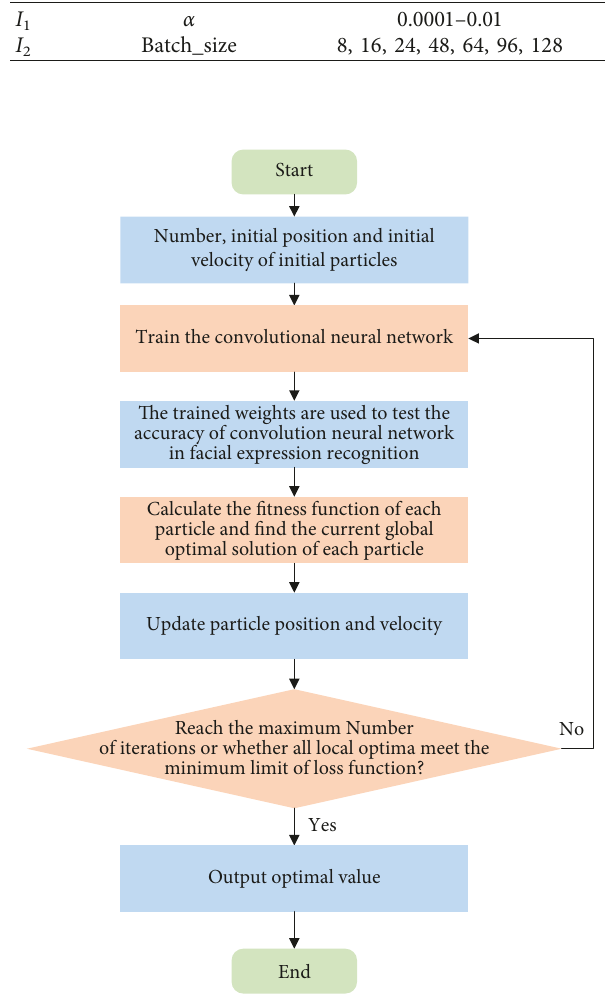
Figure 4: Particle swarm optimization algorithm flow chart.